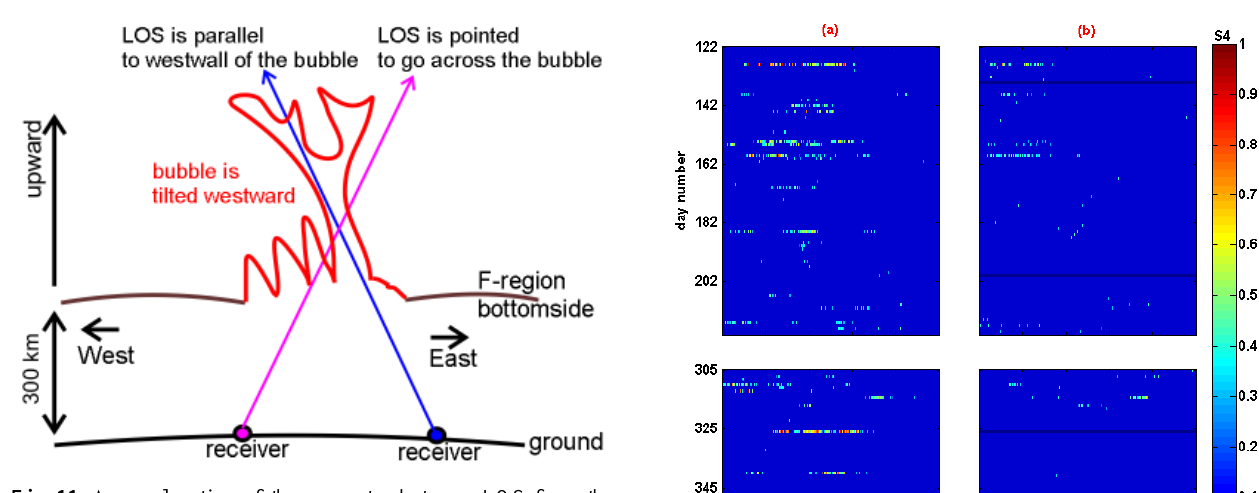
Fig. 11. An explanation of the geometry between LOS from the receiver to the east and west of the plasma bubble. Figure 11. An illustration is aimed to explain geometry between LOS from the receiver to the 3 east and west of the plasma bubble. 4